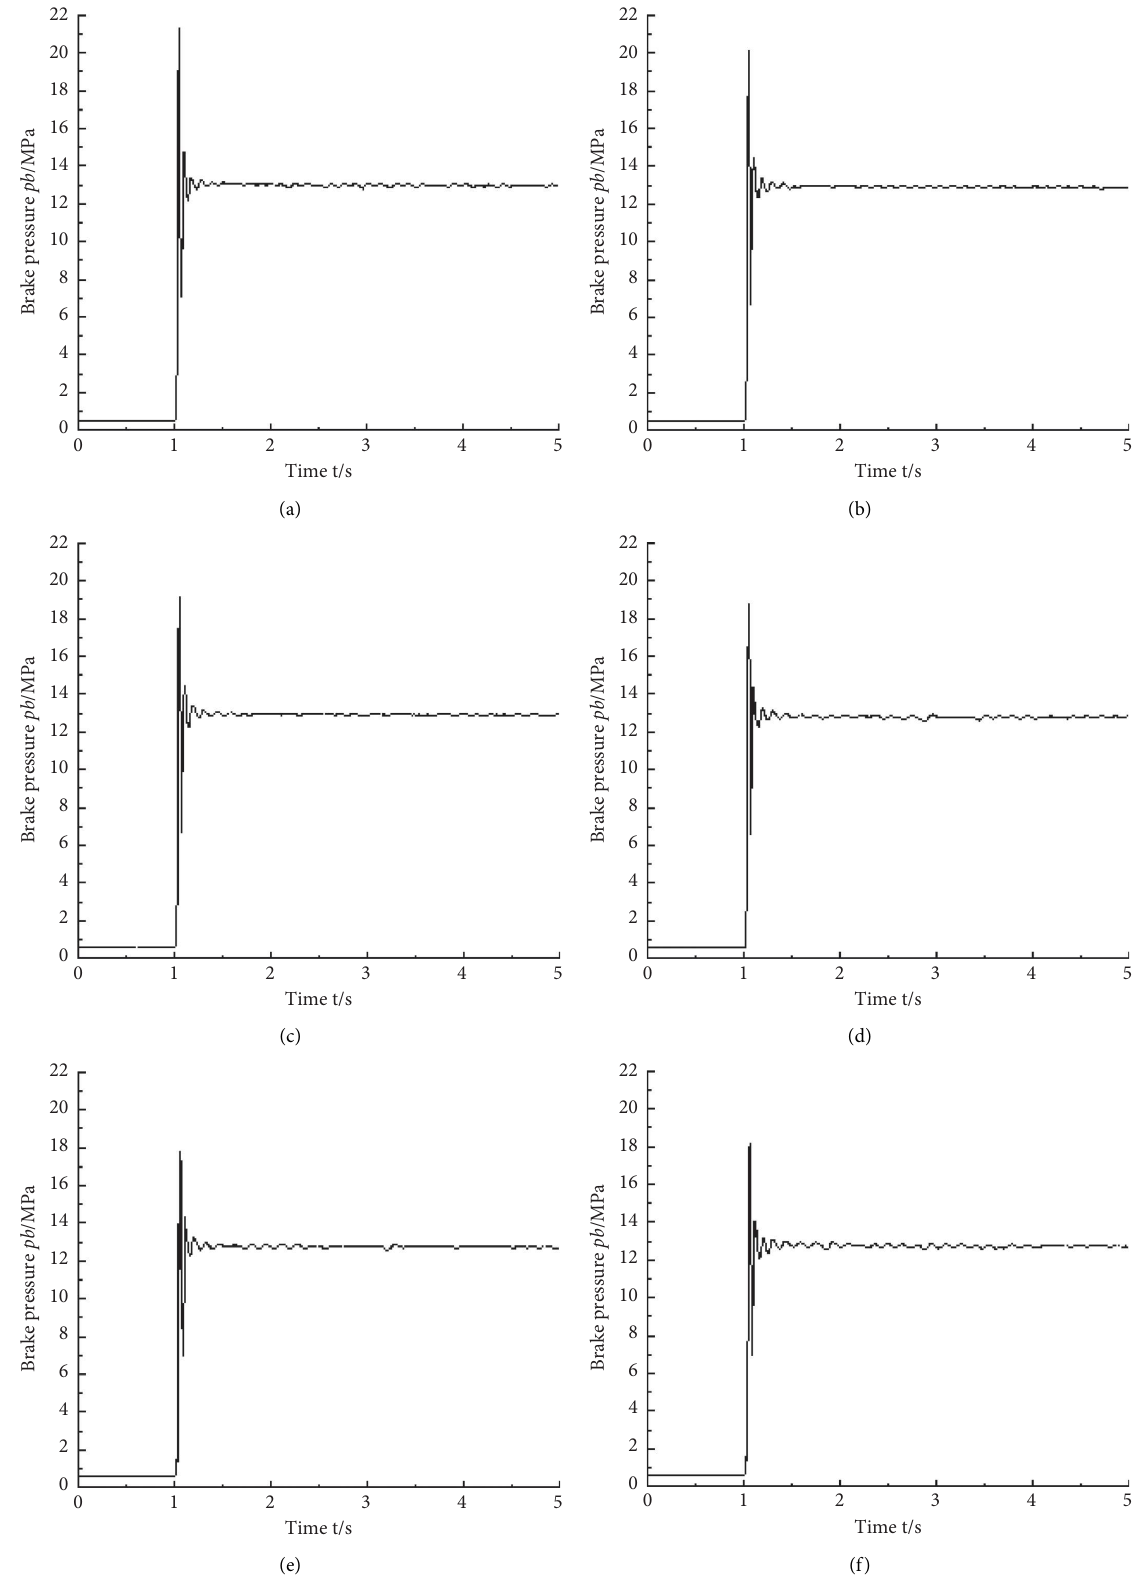
Figure 21: Pressure output of two-stage brake pressure servo valve-controlled cylinder system at 21MPa oil supply pressure. (a) 1-valve opening. (b) 2-valve opening. (c) 3-valve opening. (d) 4-valve opening. (e) 5-valve opening. (f) 6-valve